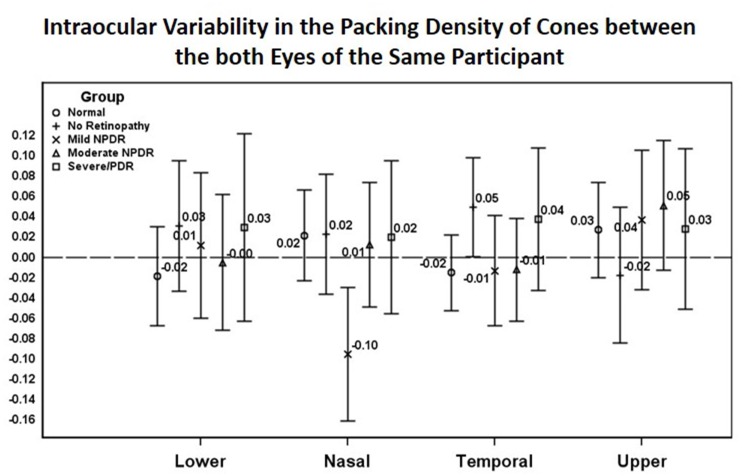
Intraocular Variability in the Packing Density of Cones between the both Eyes of the Same Participant.